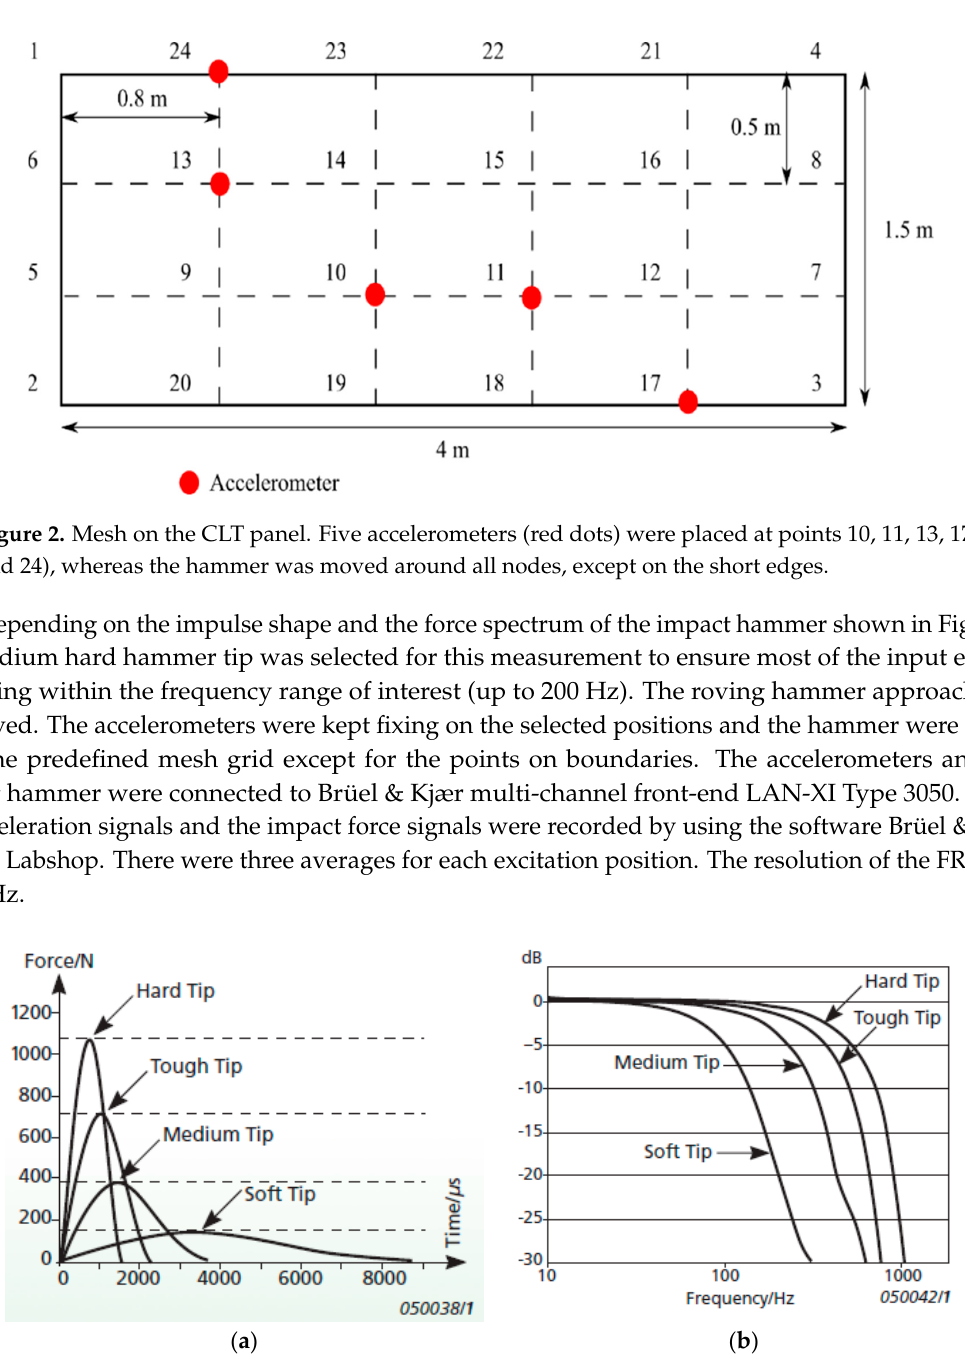
Figure 3. ( a ) Impulse shapes of the hammers showing the shape as a function of the used impact tip. ( b ) Force spectra of the hammers showing the frequency response as a function of used impact